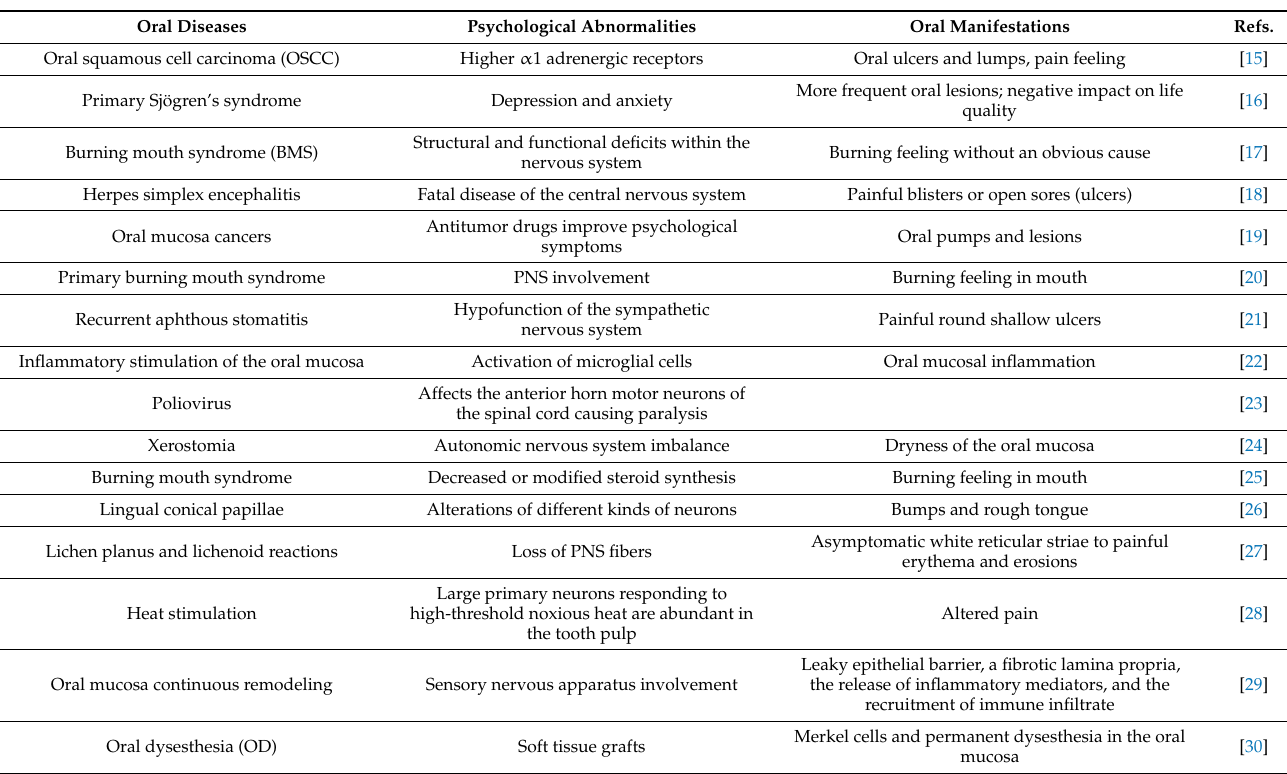
Table 2. Oral diseases with psychological